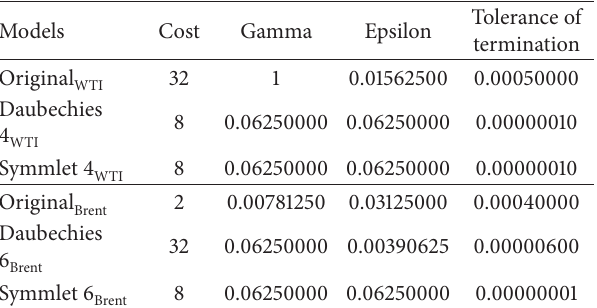
Table 1: Parameters chosen for SVR models.